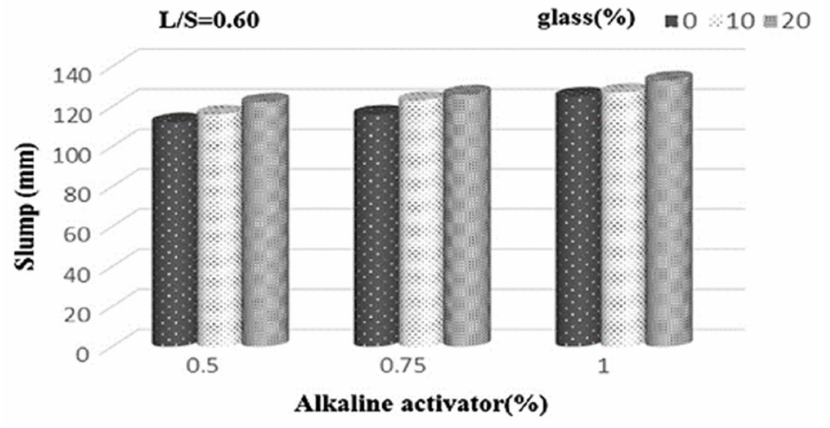
Figure 20. The slump of geopolymer concretes with varying WG powder (fineness = 2009 cm 2 /g) and activator content [67] (L/s—liquid to solid ratio; WG =